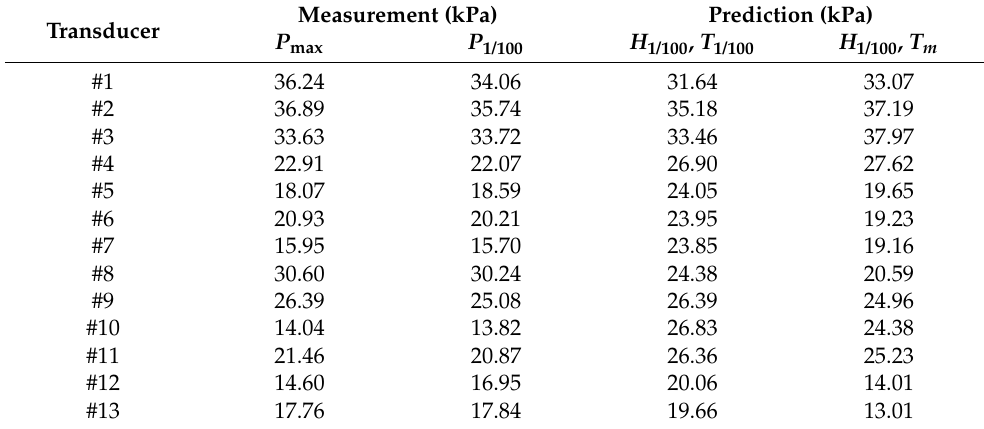
Table 2. Measurements ( P max and P 1/100 ) and predictions ( H 1/100 , T 1/100 and H 1/100 , T m ).